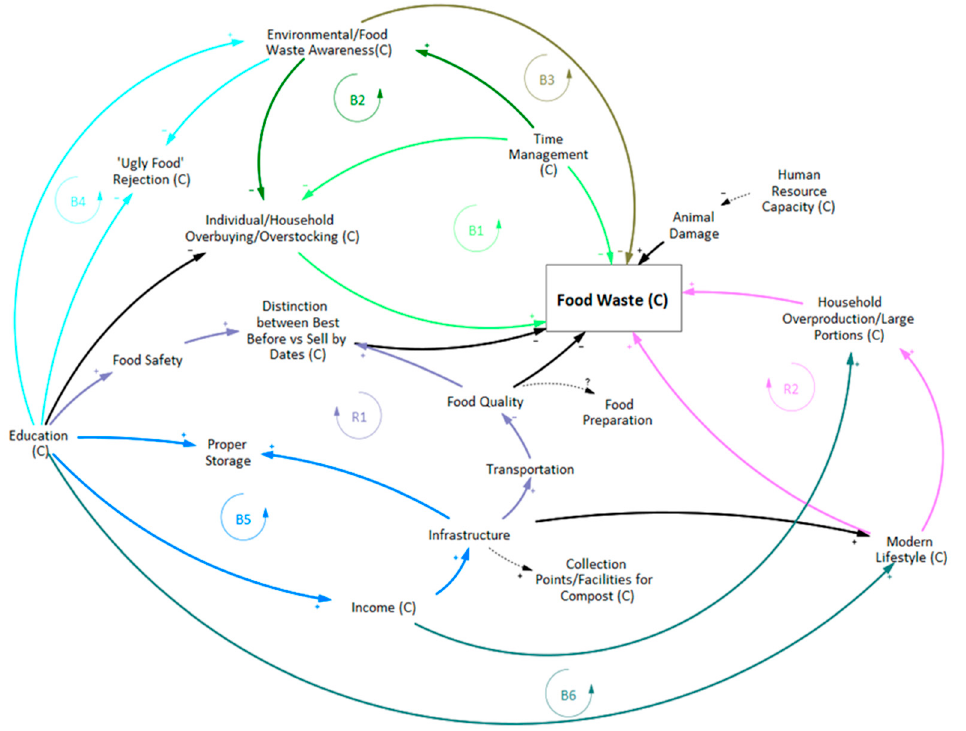
Figure A5. Food waste loop diagram elaborated during modeling session with the representatives of consumers (each color highlights a distinct loop).